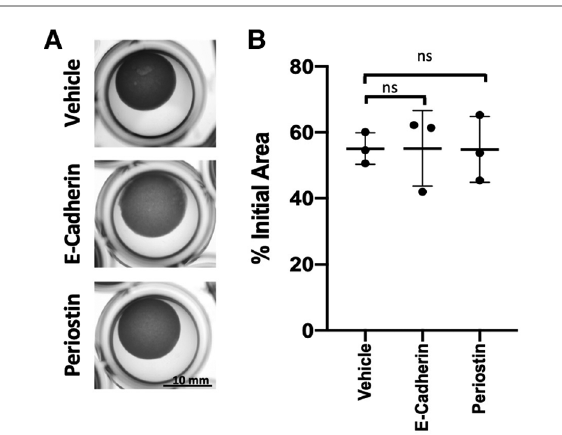
FIGURE 4 Impact of Periostin and soluble E-cadherin upon fi broblast contraction. ( A ) Representative images of FEF3-embedded collagen plugs following treatment with vehicle (PBS), E-Cadherin (10 μ g/ml) or Periostin (500 ng/ml) for 72 h. ( B ) Quantitative analysis of fi broblast-mediated gel contraction. Relative plug area was obtained by measuring fi nal dimensions in comparison with initial area. Each dot represents mean for one independent experiment performed in triplicate and bar represents mean±SD. Statistical analysis was performed using two-way ANOVA (ns, not signi fi